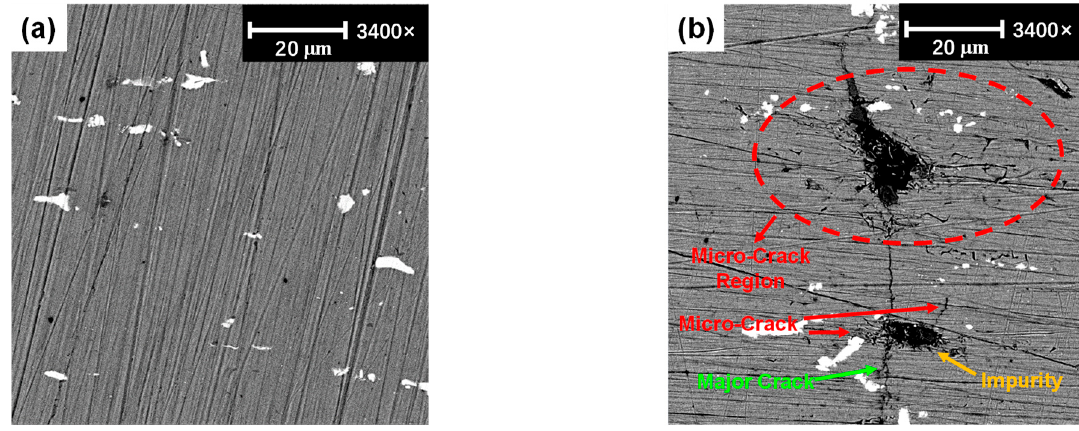
Figure 14. SEM images of the specimen. ( a ) The non-crack damage region. ( b ) The tip region of the major crack.